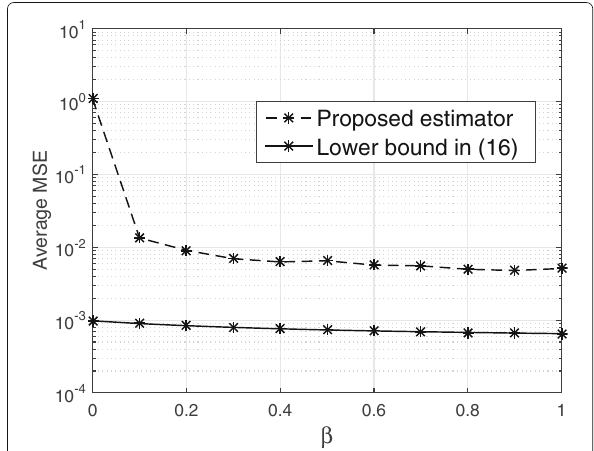
Fig. 3 MSE performance of the proposed channel estimator for different values of β for E b / N 0 = 0 dB, N = 128, and SIR = − 50 dB